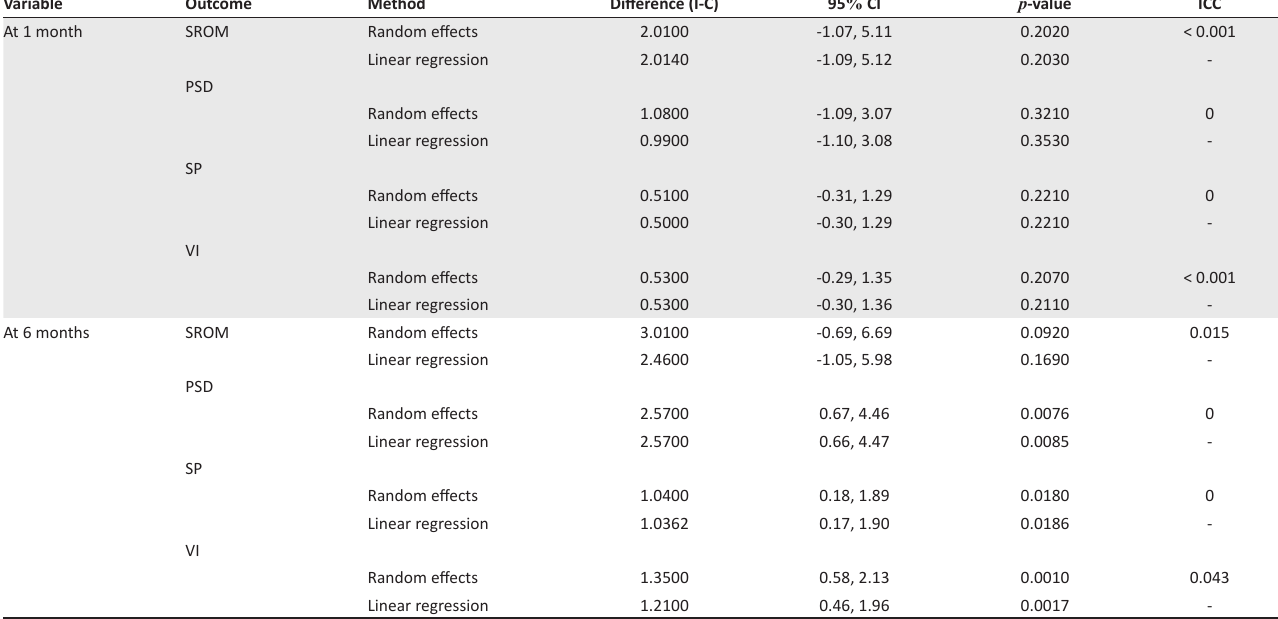
TABLE 3: Sensitivity analysis of treatment effect at 1 and 6 months on the stuttering resource outcomes measure sub-scales ( p = 0.001).